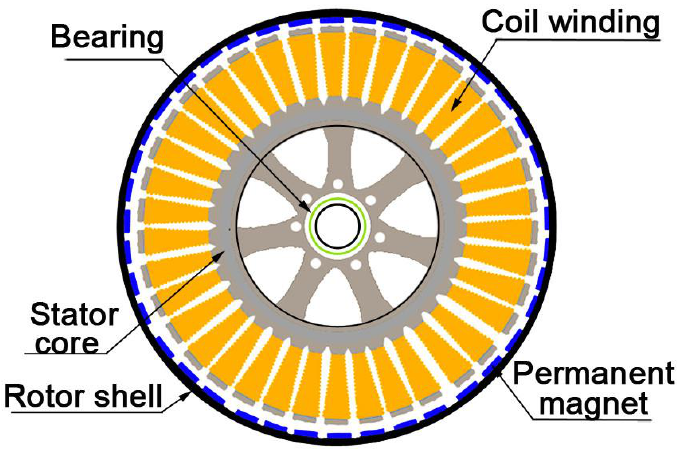
Figure 4. Brushless motor inner design by [37].